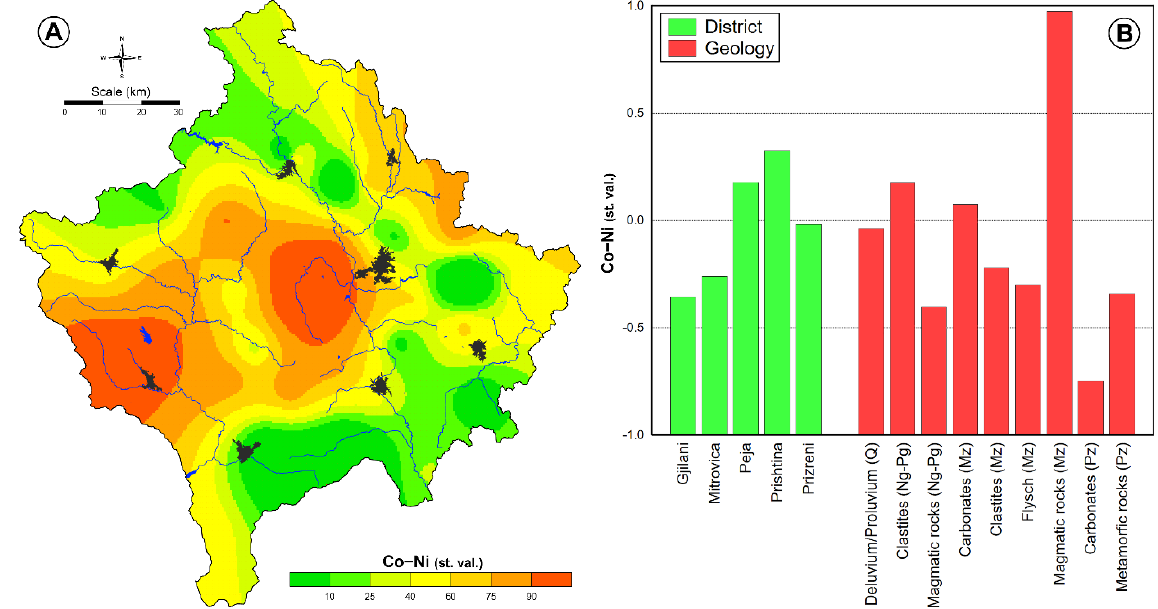
Figure 8. Spatial distribution of factor scores of F4 ( A ) and standard values according to the districts and geological formations ( B ).